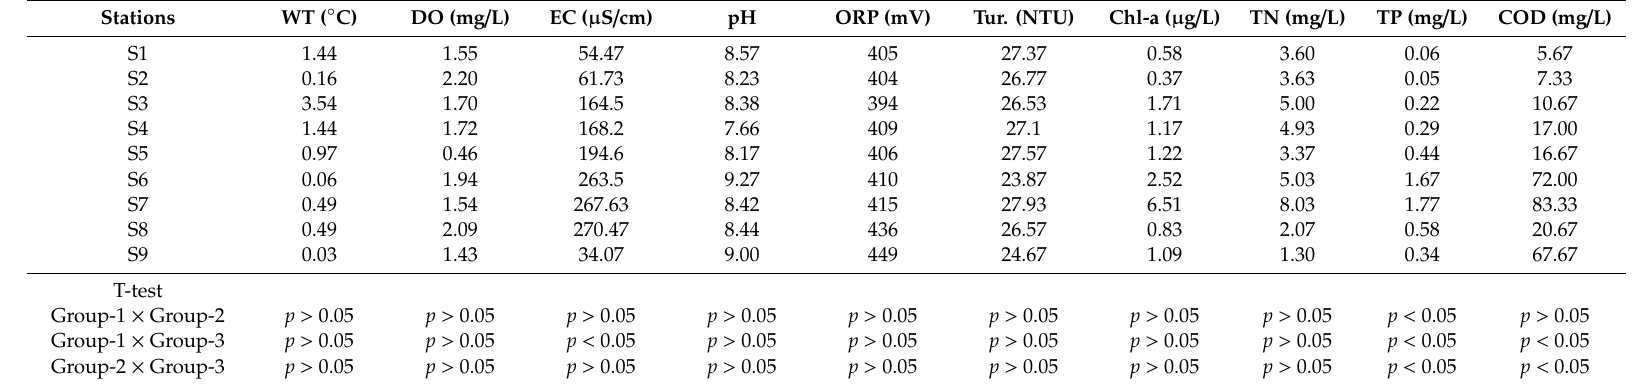
Table 1. Environmental factors in Lalin River Basin (LLRB) during ice-covered period in 2018.